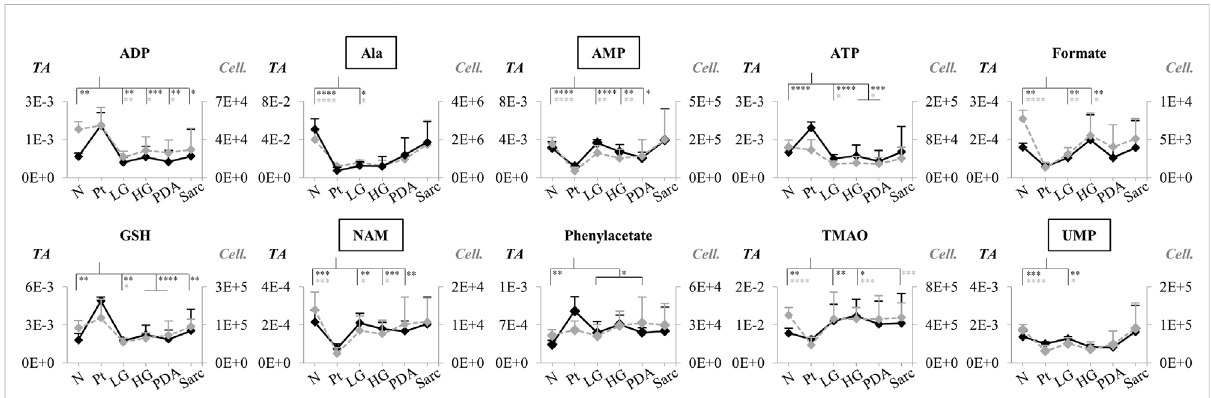
FIGURE 3 Variationsin10metabolitesdistinguishingPttissuefrombothNandLGtissues(GPCvariationsareleftoutastheybecomenon-signi fi cantupon FDR correction, d in Table 2), represented as normalized peak integrals, either in relation to total spectra area (TA) ( Tissue signature: left axes, fi lled black lines) or cellularity ( Cell signature: rightaxes, dashed grey lines). Asterisks indicate statistical relevanceof pairwise comparisons inrelation to Pt (black and grey asterisks correspond to TA and Cell. data, respectively): p p -value < 0.05, pp p -value < 0.01, ppp p -value < 0.001, pppp p -value < 0.0001. Boxed metabolite names refer to those suggested to re fl ect intracellular metabolic variations (similar black and grey lines, for the N, Pt